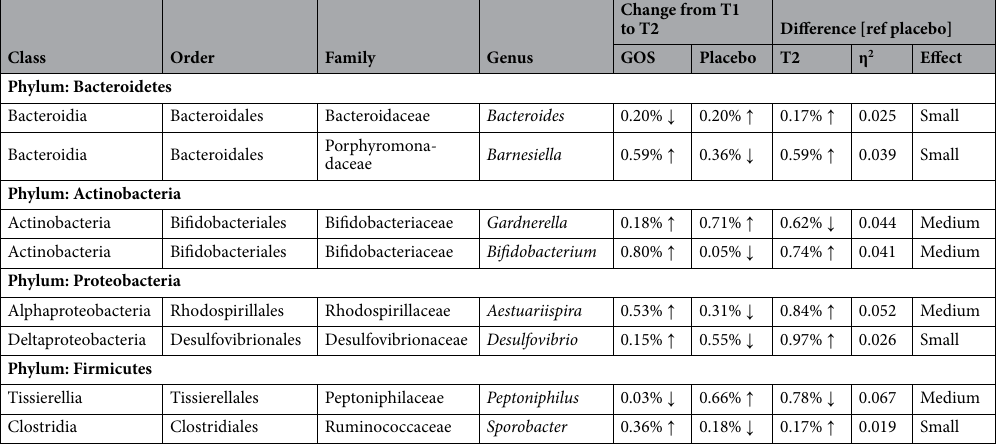
Table 1. Sample taxa resulting from differential abundance testing of intervention effects. Differential taxa identified at follow up (T2) from ANCOVA models. Descriptive changes in abundance from baseline (T1) measures to follow up are displayed for each intervention group and effect size of abundance group difference at T2. Upward arrows represent an increased/more abundance, and downward arrows decreased/less abundance